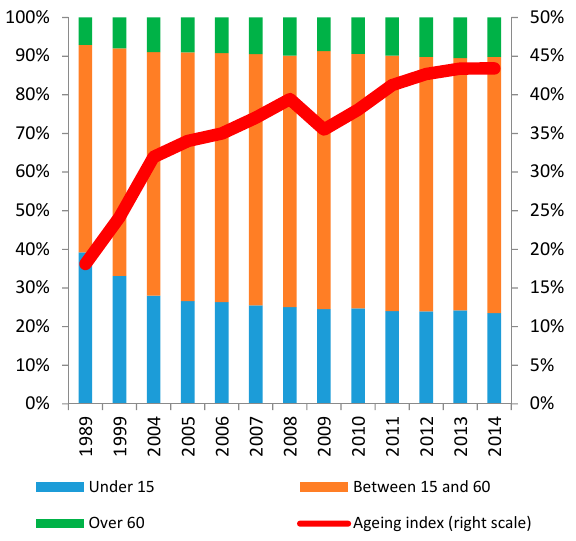
Figure 3. Population structure and ageing index.